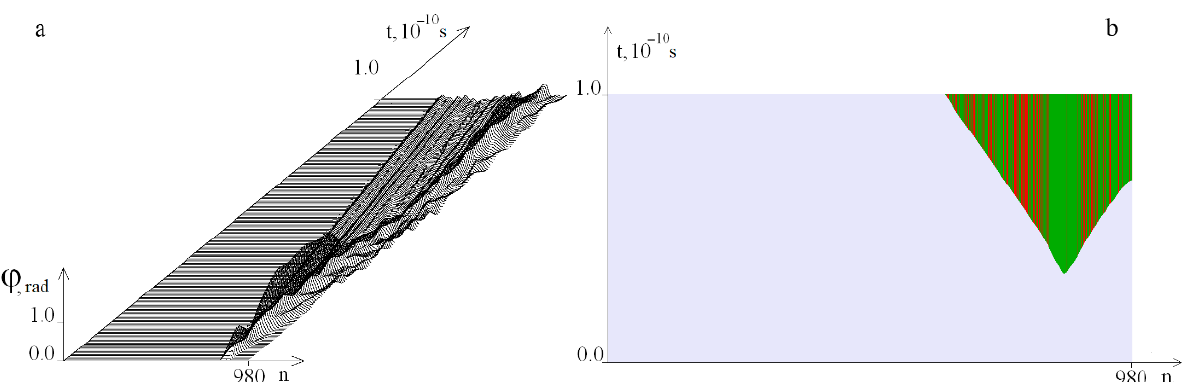
Figure 16. Influence of localized torque on a segment [831, 880]. ( a )—Graph of the angular deviations of the first strand of the DNA molecule on the time interval [0, T 0 ] at M 0 = 18.232. ( b )—OS regions at M 0 = 18.233, green color indicates OS in A–T pairs, red, in G–C pairs.